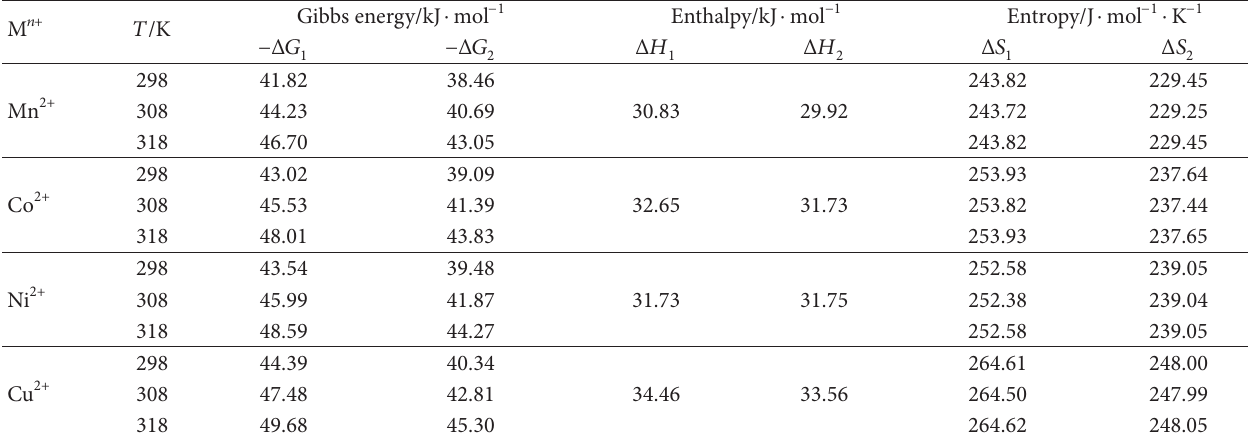
complexes of ligand (L 2